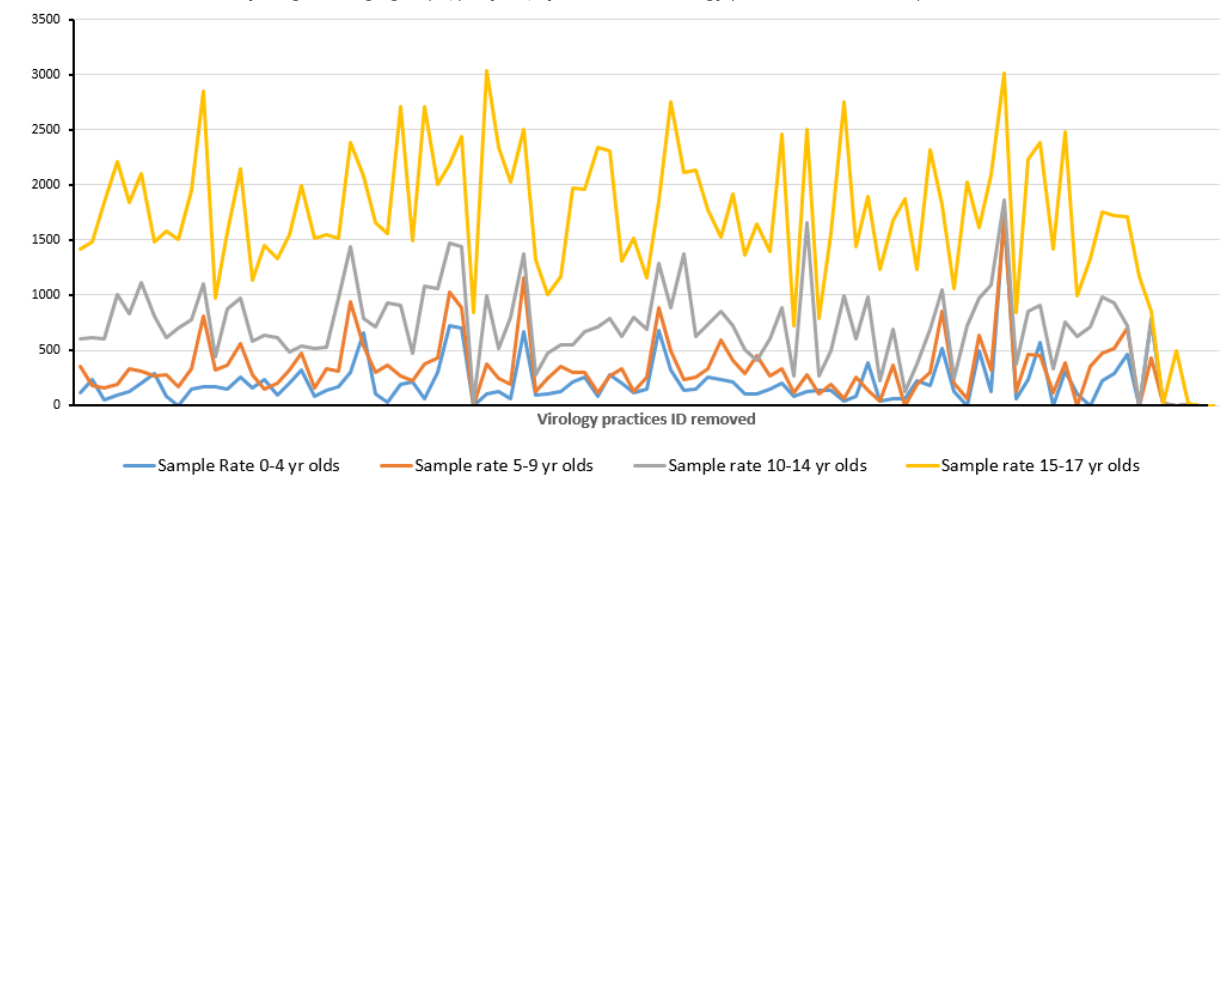
Figure 8. Variation of blood sampling in children and young adults according to age. Data on rate of full blood count sampling per 100,000 registered patients for each children and young adult age groups, per year, by individual virology practice. Practice unique identifiers have been